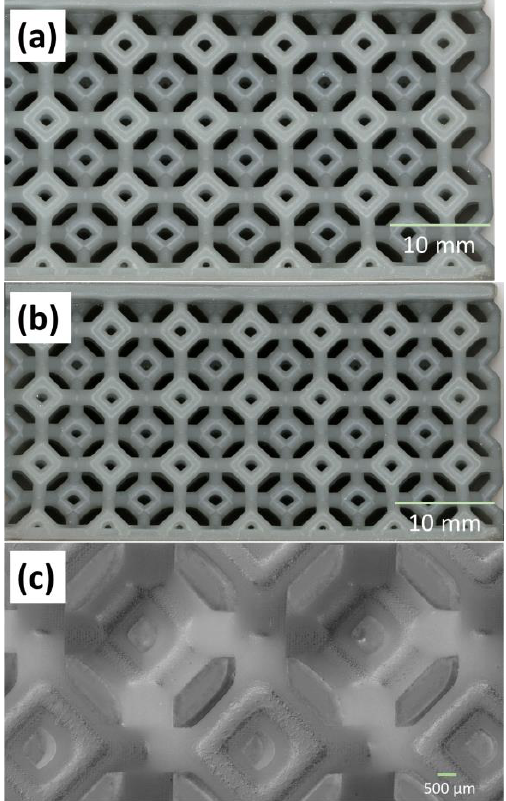
Figure 12. Micrographs of the SIL30 sample ( a ) before impact, ( b ) after impact and ( c ) high magni- fication view post